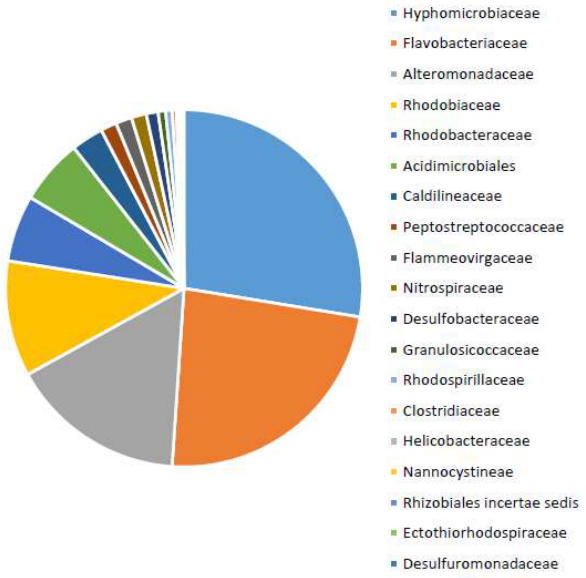
Figure 5. Relative abundance of the common bacterial taxa from the anoxic intertidal zone of the River Dee estuary. Data obtained from 16S rRNA gene sequences.